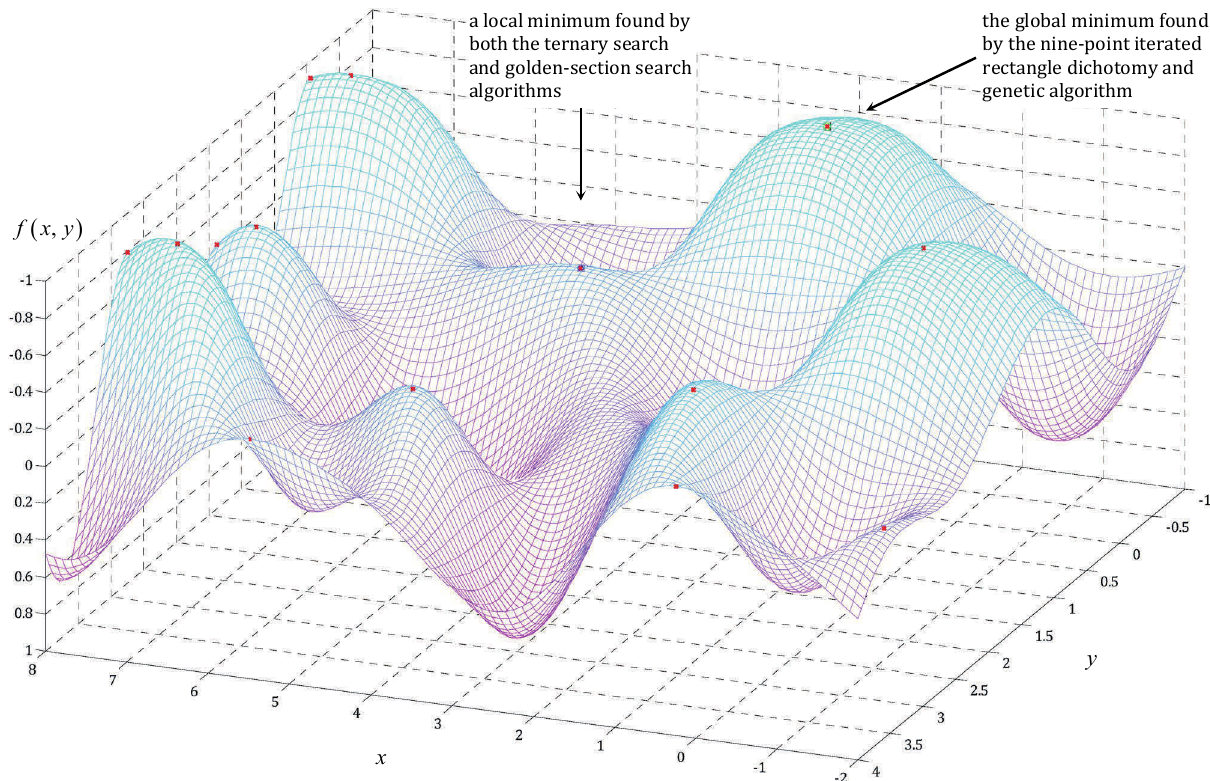
Fig. 7. The 15 local minima (one of which is unseen from this view angle), including both the local boundary minima and the global minimum of surface (89) on rectangle (90) (the surface value axis is shown in reverse direction for easier observation of